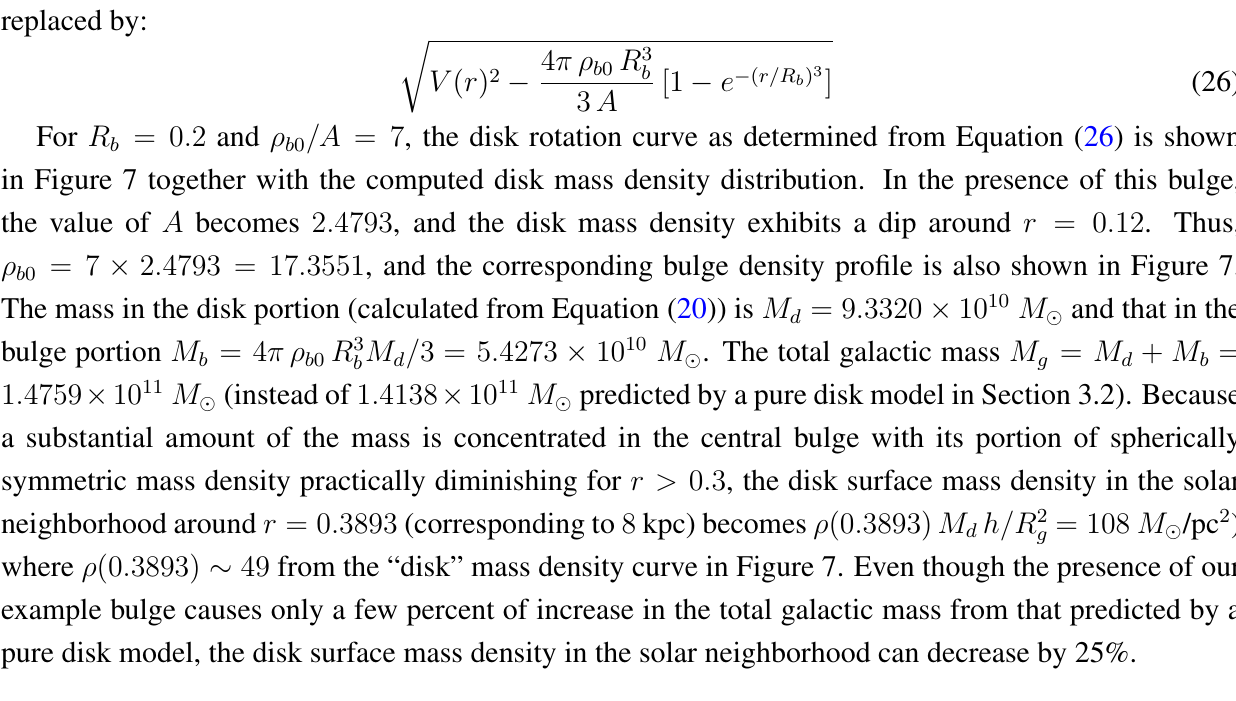
Figure 7. Profiles of the Milky Way rotation velocity and mass density for the disk portion = 0 . 2 and ρ /A = 7 ) as noted along with that in Figure 3 (thick and bulge portion (with R b b 0 line) as a